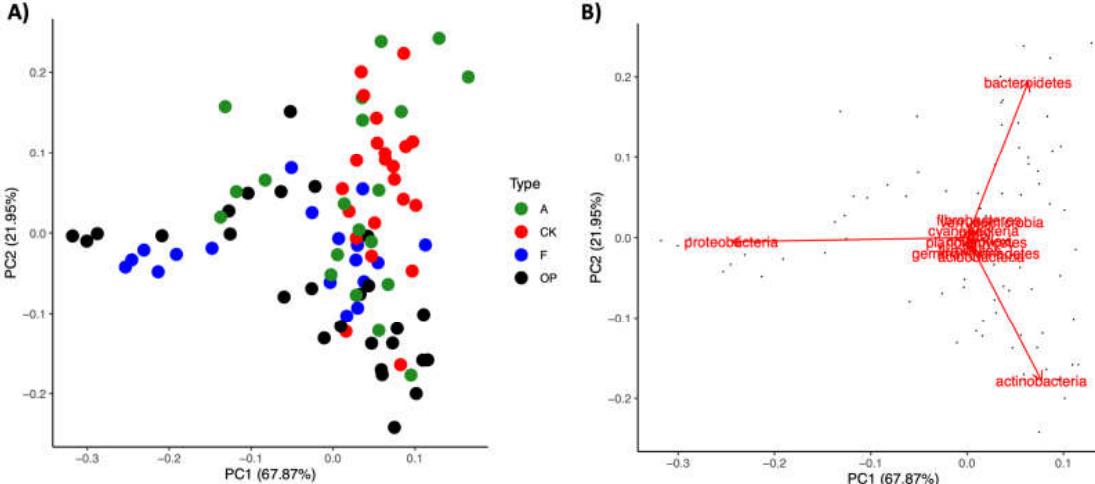
Figure 2. Principal components analysis of dune microhabitats (blowout (OP), A. breviligulata ( A ), C. kobomugi (CK), and foredune toe (F)) microbiomes based on percentage community composition at the phylum level. All the samples collected in this study are shown based on their respective microhabitat (A) and with arrows representing the vectors of factor loadings ( B ). The percent variation explained by the PCs of the principal components analysis is indicated on the